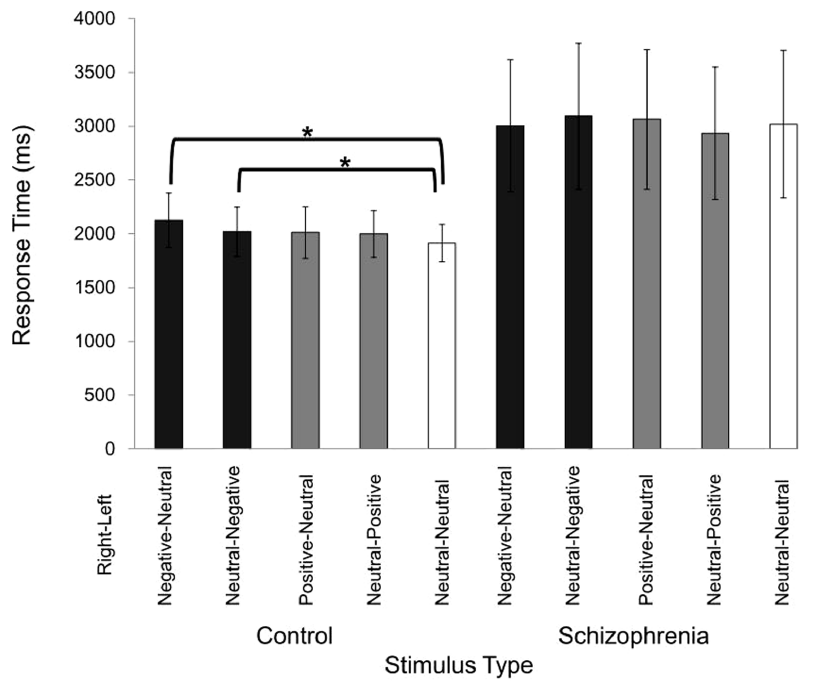
Figure 2. Effect of auditory negative words on response time in healthy subjects and patients with schizophrenia. Response times for Negative-Neutral, Neutral-Negative stimuli on the right-left side were significantly longer than that for Neutral-Neutral word pairs, irrespective of direction of attention in the healthy controls (p=0.0035, p=0.025, respectively). In contrast, response time for Positive-Neutral (p=0.11), Neutral- Positive (p=0.12) word pairs on the right-left side was not significantly longer than that for Neutral-Neutral word pairs.